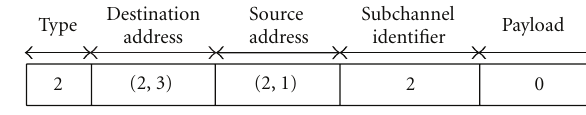
Figure 10: Outgoing set-up packet allocator EAST (2,2).